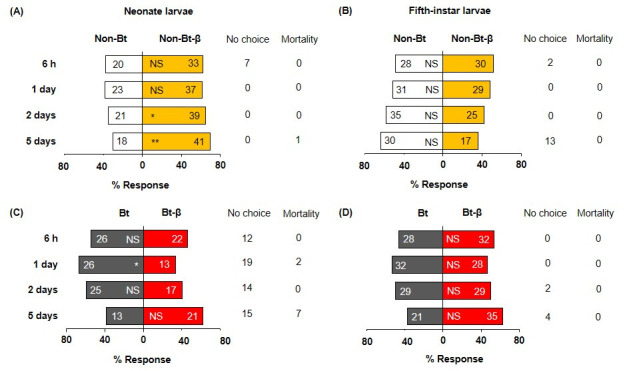
Food choices of Ostrinia nubilalis larvae when β-carotene is incorporated into Bt and non-Bt diets.β-carotene (denoted as β) was added to semi-artificial diets with Bt protein or without (Non-Bt), then offered to neonate (A, C) and fifth-instar (B, D) larvae. Sixty individuals per instar were tested (n = 60), and their location (on or off diet) were recorded at four time points (6 h, 1, 2, and 5 d). Each bar displays number of larvae on each diet. Off-diet or dead larvae were excluded from the analysis; their counts are shown next to each bar under ‘No choice’ and ‘Mortality’, respectively. Asterisks indicate significant differences between diets (X2, *P = 0.05, **P = 0.01, ***P < 0.001). NS, not significant. See the Materials and Methods section for detailed diet components.